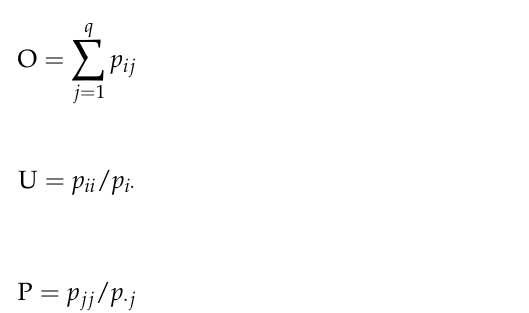
Figure 8. Flowchart for extracting farm lands, roads and squares, and buildings.